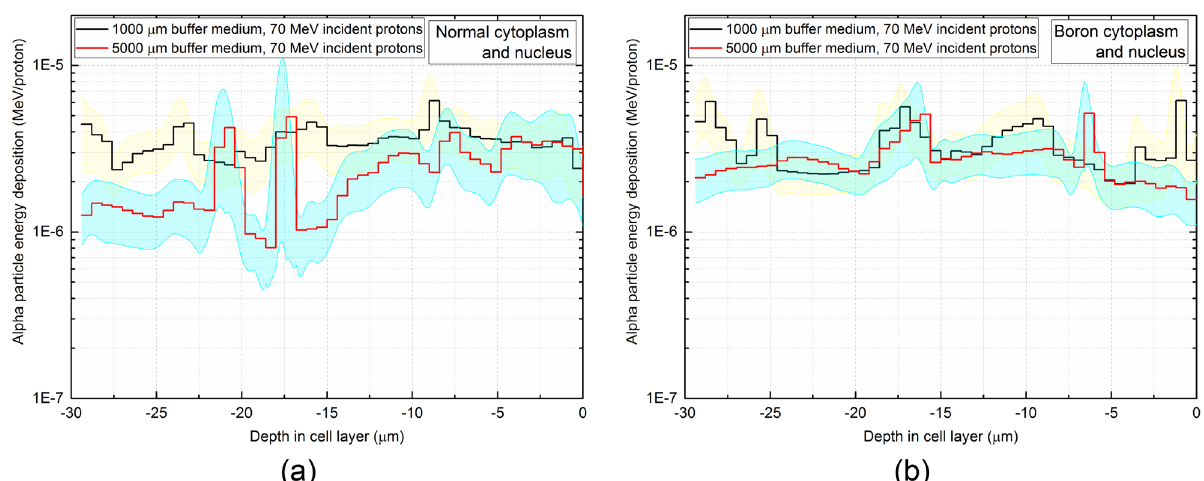
Figure 8. Axial energy deposition of alpha particles in the cell layer impinged by 70 MeV protons having ( a ) normal, ( b ) boron filled cytoplasm and nucleus. The yellow and blue highlight represent the statistical uncertainties associated with the Monte Carlo computations for 1000 and 5000 μm buffer medium thickness,